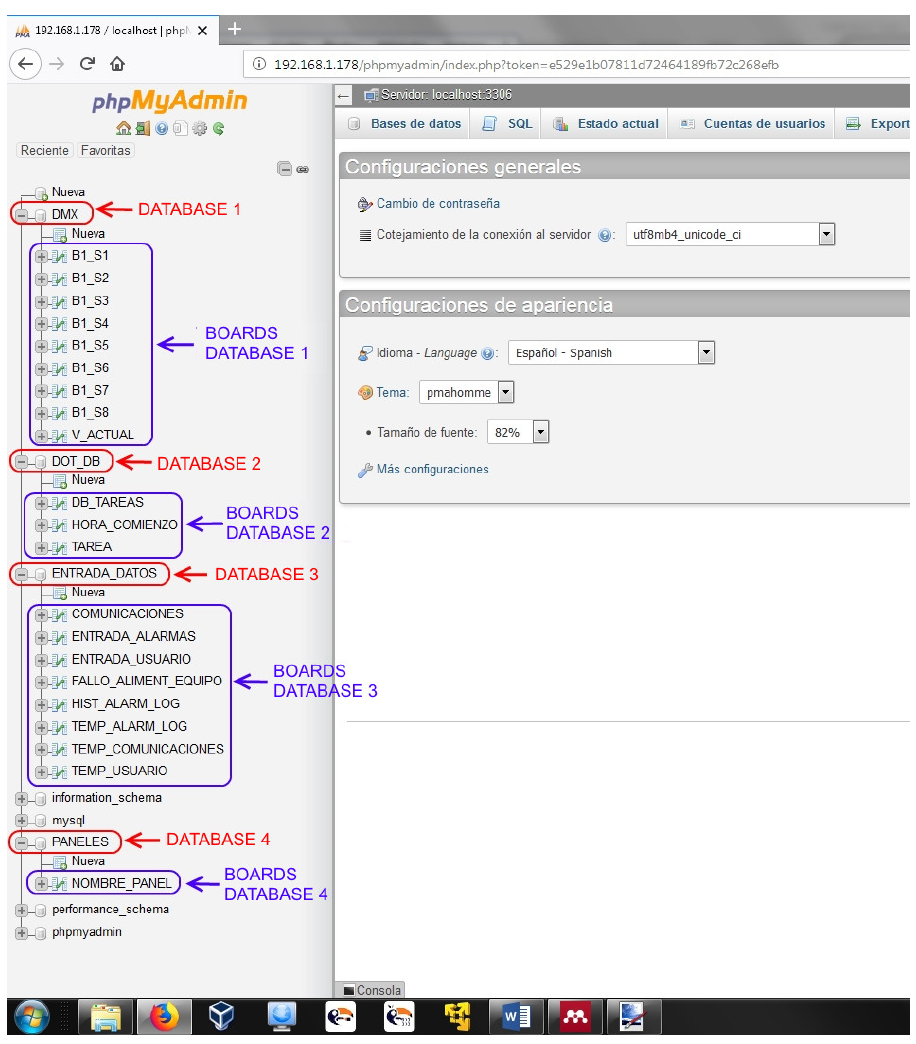
Figure 10. Platform databases.